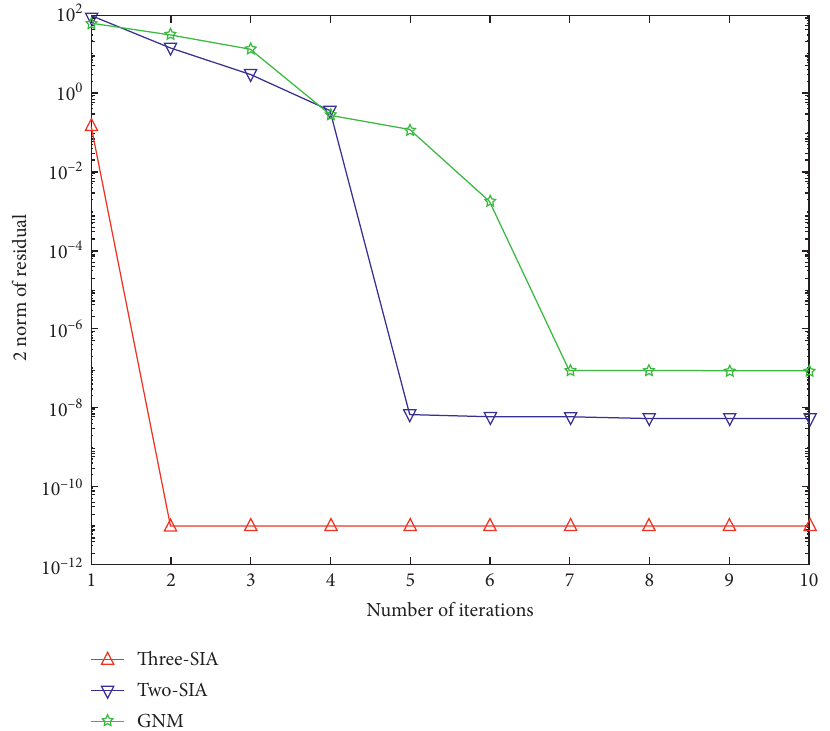
Figure 2: The convergence curve of three-SIA, two-SIA, and GNM for Example 6.